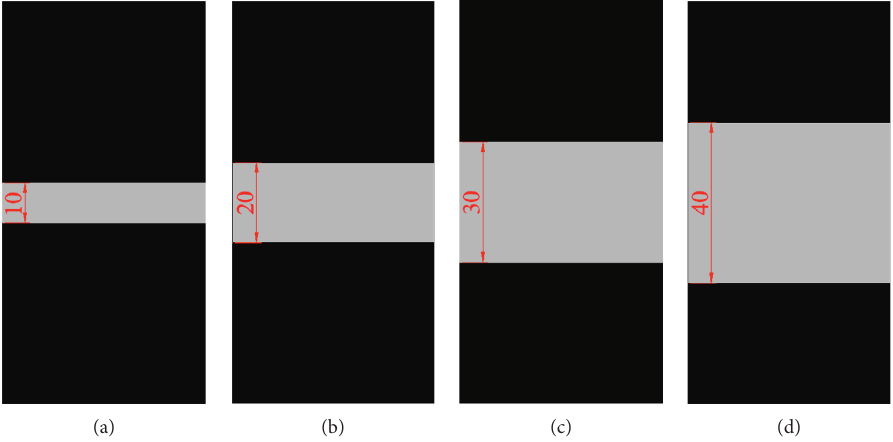
Figure 2: Composite specimens with different rock-parting thicknesses ( D ). (a) 10mm. (b) 20mm. (c) 30mm. (d) 40 mm.